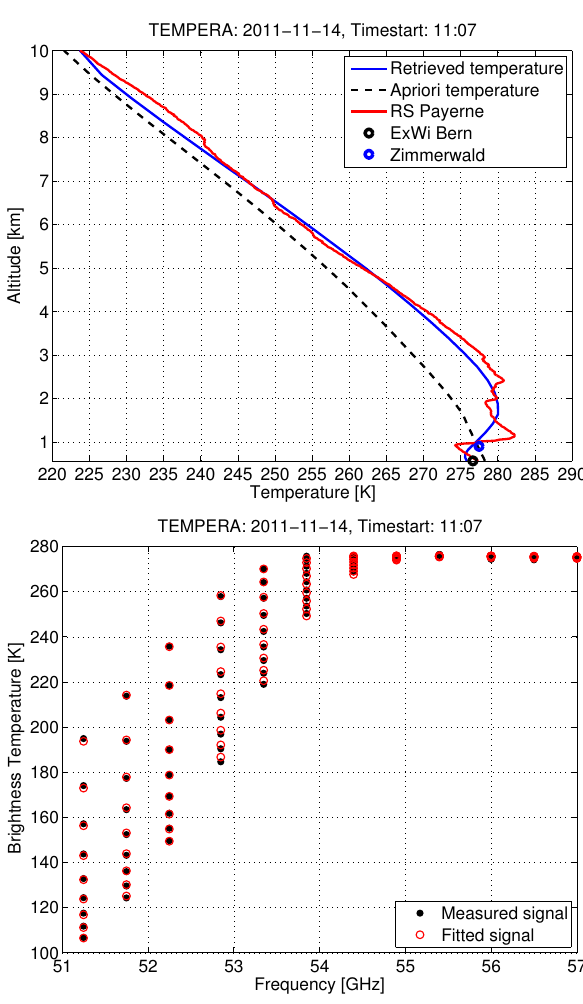
Fig. 7. Measurement of 14 November 2011 at 11:07–11:22 (UT) during clear sky (ILW=0mm). Upper panel: retrieved temperature profile (blue line). The a priori profile is the dashed black line; com- parison with radiosonde data from Payerne (red line), with weather station data from Bern (black circle), and with Zimmerwald (blue circle). Lower panel: brightness temperatures of 12 channels mea- sured with TEMPERA (black dots) compared with the forward model brightness temperatures (open red dots) corresponding to the retrieval.